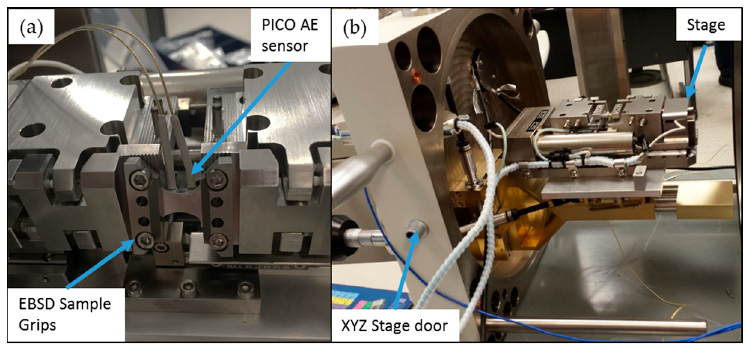
Figure 1. Experimental mechanics setup including a screw-driven stage used for tensile testing of Magnesium polycrystals inside the Scanning Electron Microscope: ( a ) The loading stage with sensors and sample attached on the EBSD grip which is pre-tilted 70°; ( b ) The XYZ stage door with stage on the door.